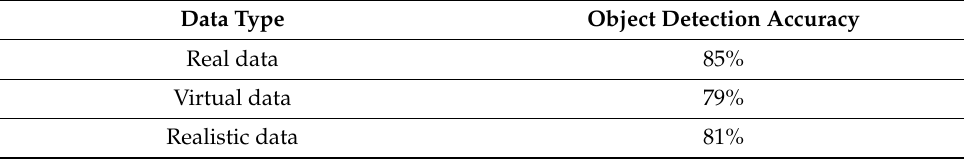
Table 4. Comparison results of object detection